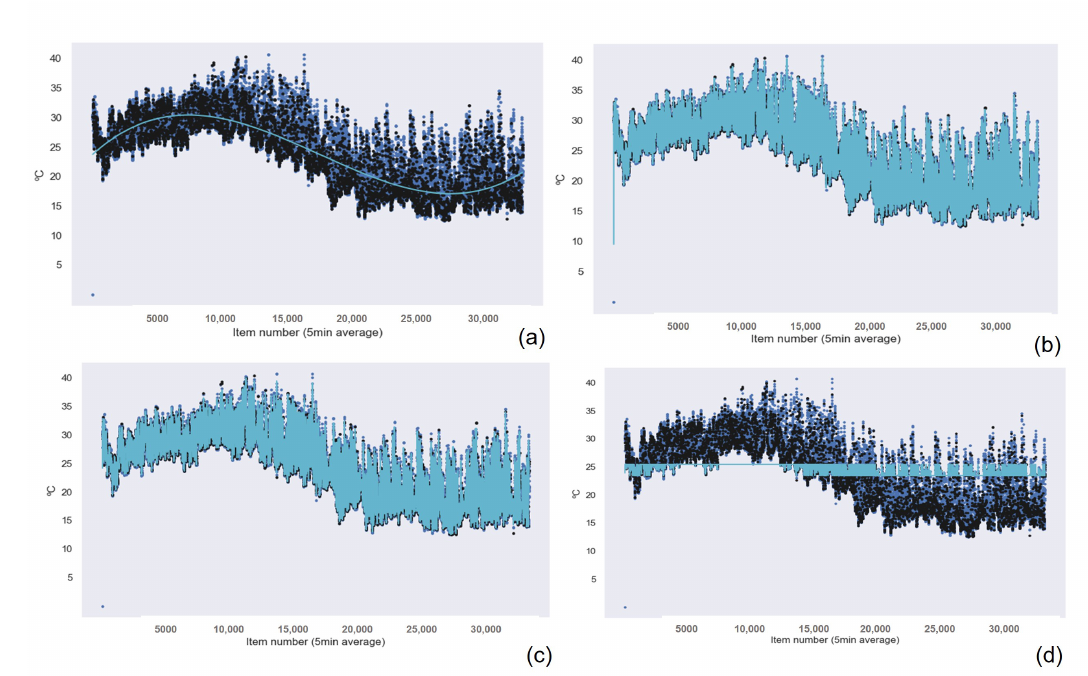
Figure A13. Temperature results for the articulate matter measuring device # 1 for ( a ) Linear Regres- sion ( b ) Random Forest Regression ( c ) KNN and ( d ) Support Vector Machine.